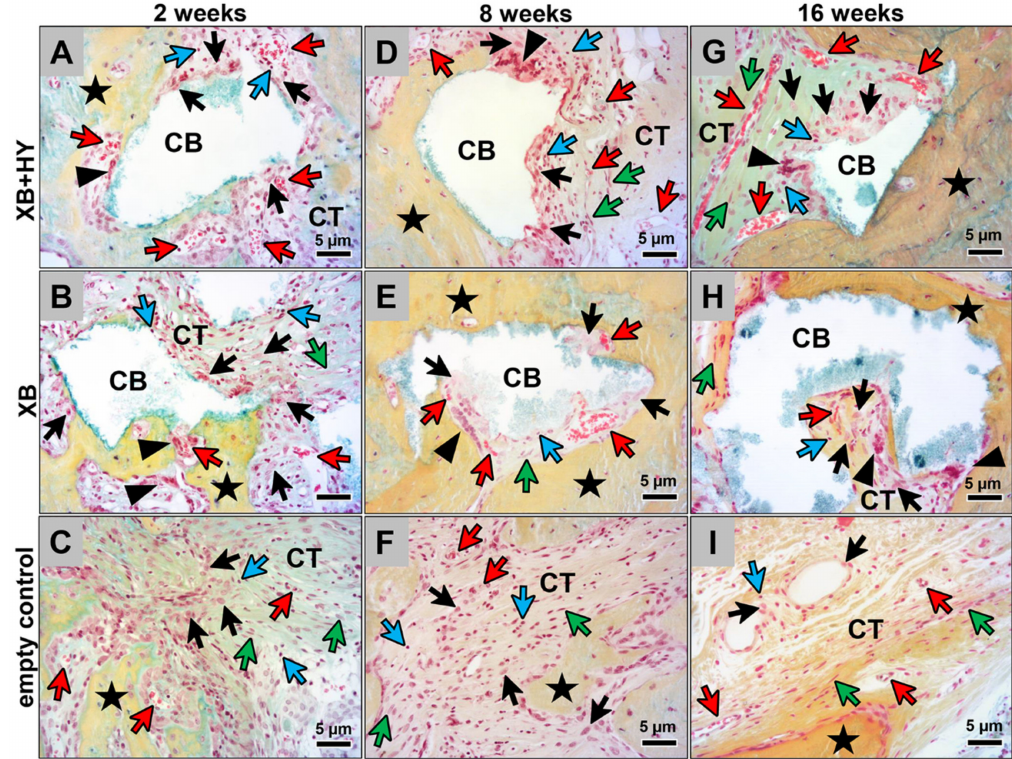
Figure 2. Exemplary histological images of the tissue responses to the BSM in the different study groups at 2 weeks ( A–C ), 8 weeks ( D–F ), and 16 weeks ( G–I ) post implantationem. At the material-tissue-interfaces, mainly macrophages in concert with single multinucleated giant cells were detectable. Within the surrounding connective tissue (CT) mainly macrophages, fibroblasts, and low numbers of lymphocytes were found in all study groups. Yellow arrows = macrophages, green arrowheads = multinucleated giant cells, violet arrows = lymphocytes, red arrows = blood vessels, blue arrows = fibroblasts, black stars = newly formed bone (Movat ´ s Pentachrome stainings, 400 × magnifications, scalebars = 5 µ